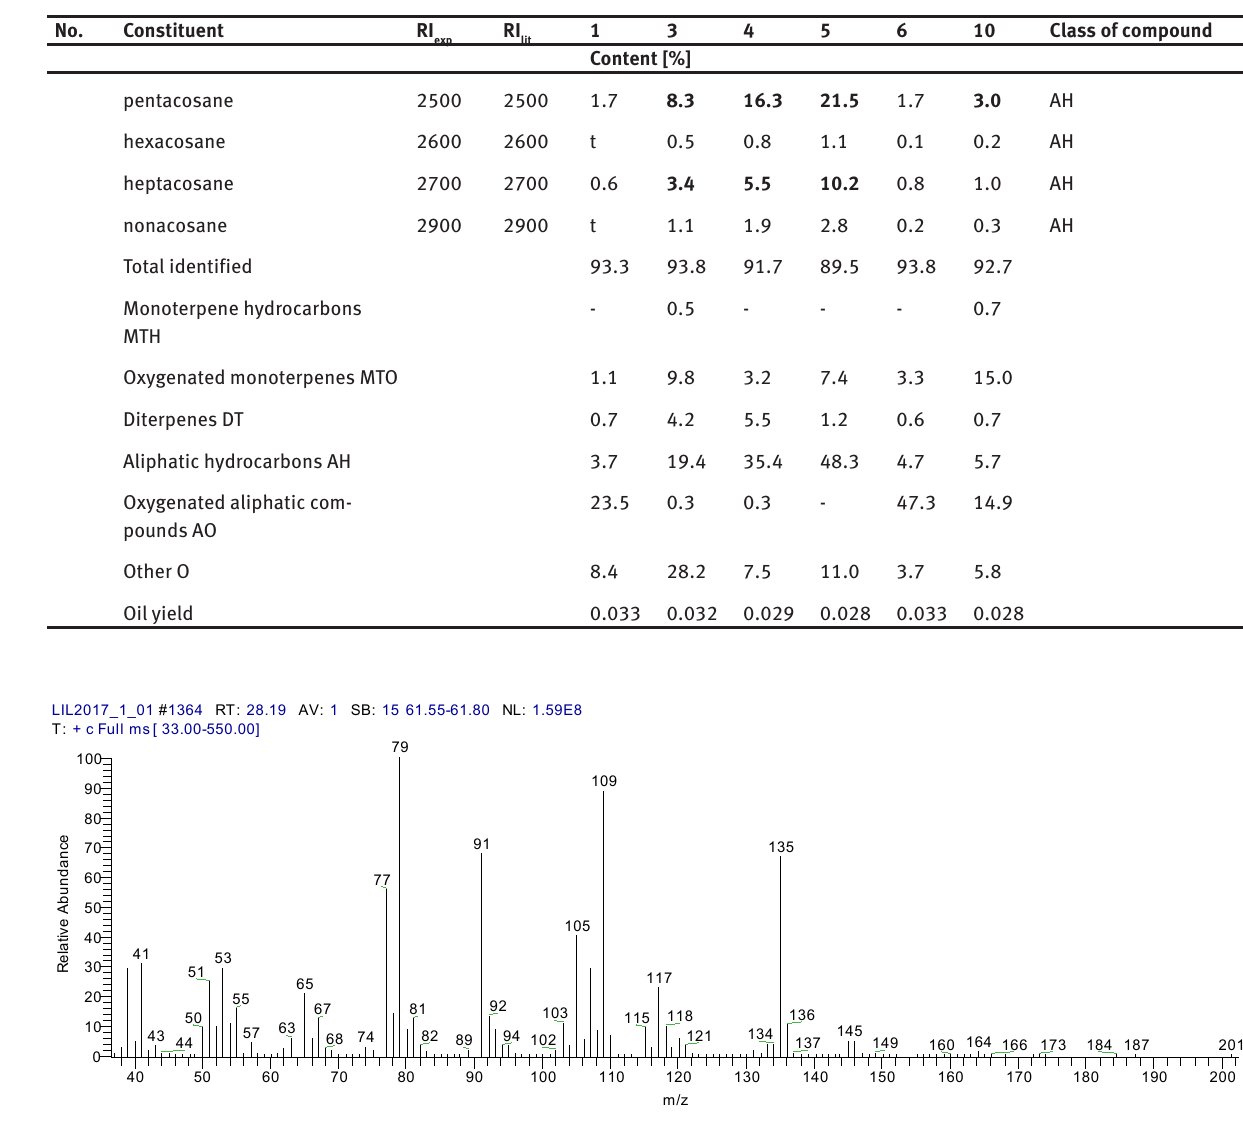
Table 3: Composition of essentials oils of Hemerocallis cultivars aerial parts: 1 – H. ‘Rebel Cause’; 3 – H. ‘Catherine Woodbuery’; 4 – H. Continued fulva ; 5 – H. ‘Chicago Apache’; 6 – H. ‘Danuta’; 10 – H. ‘Aten’. RI